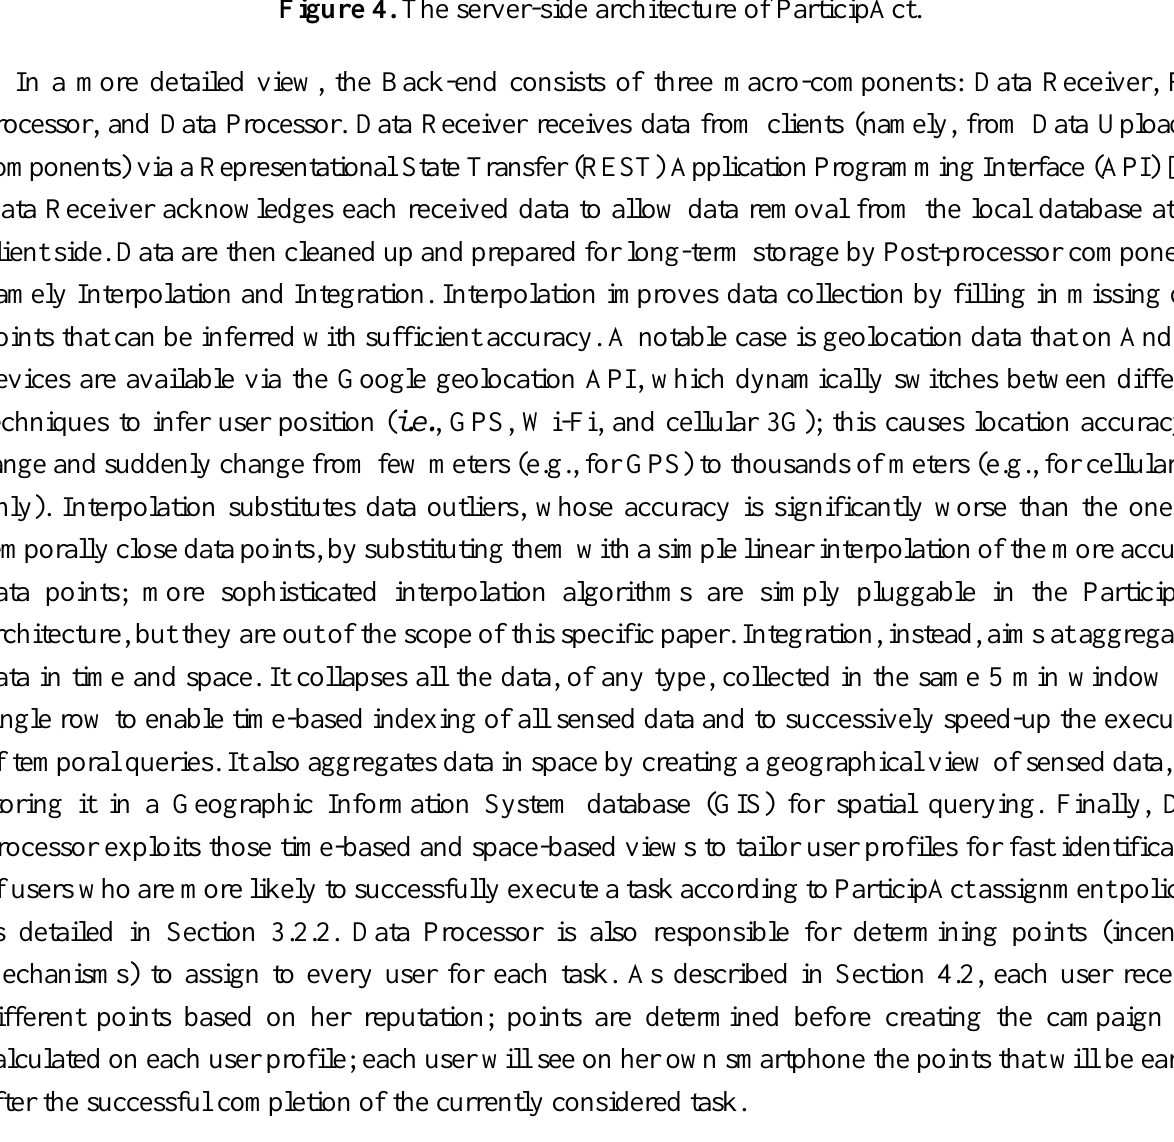
Figure 4. The server-side architecture of